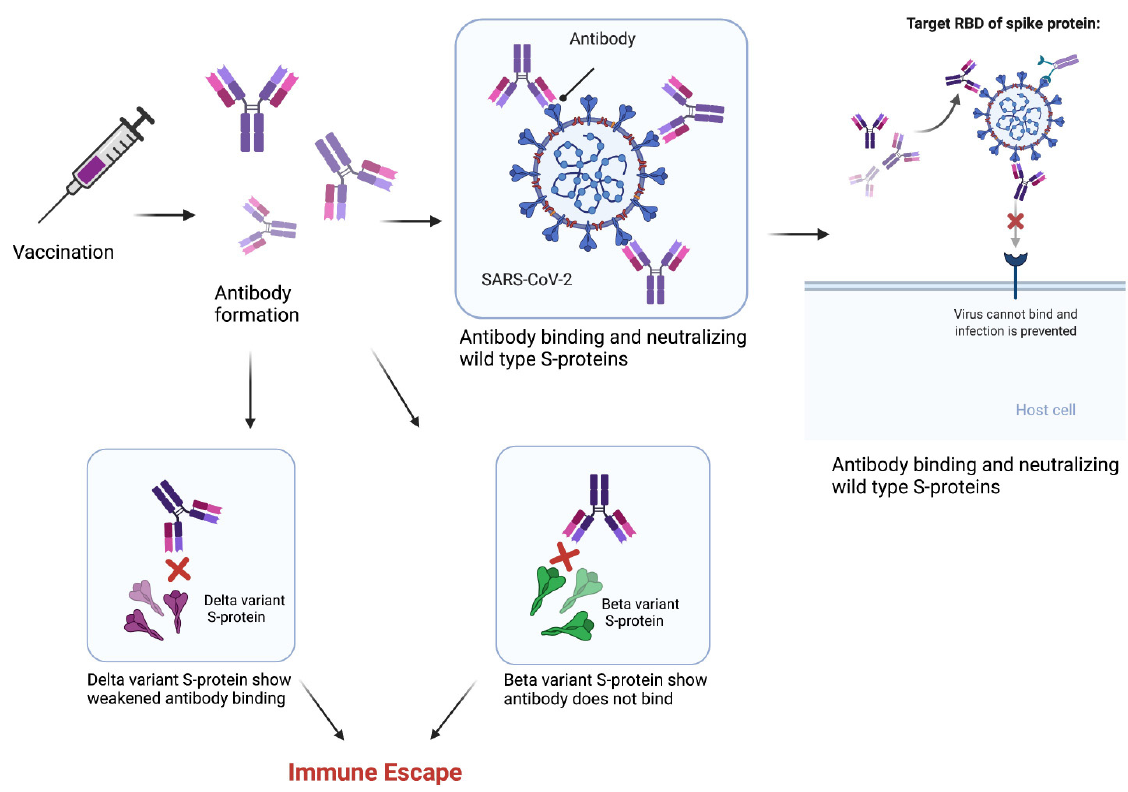
Figure 7. Mechanisms of antibody-mediated neutralization of viruses by blocking the binding to cell surface receptors and as a result inhibiting or dampening the infectivity. Created with BioRen- der.com.